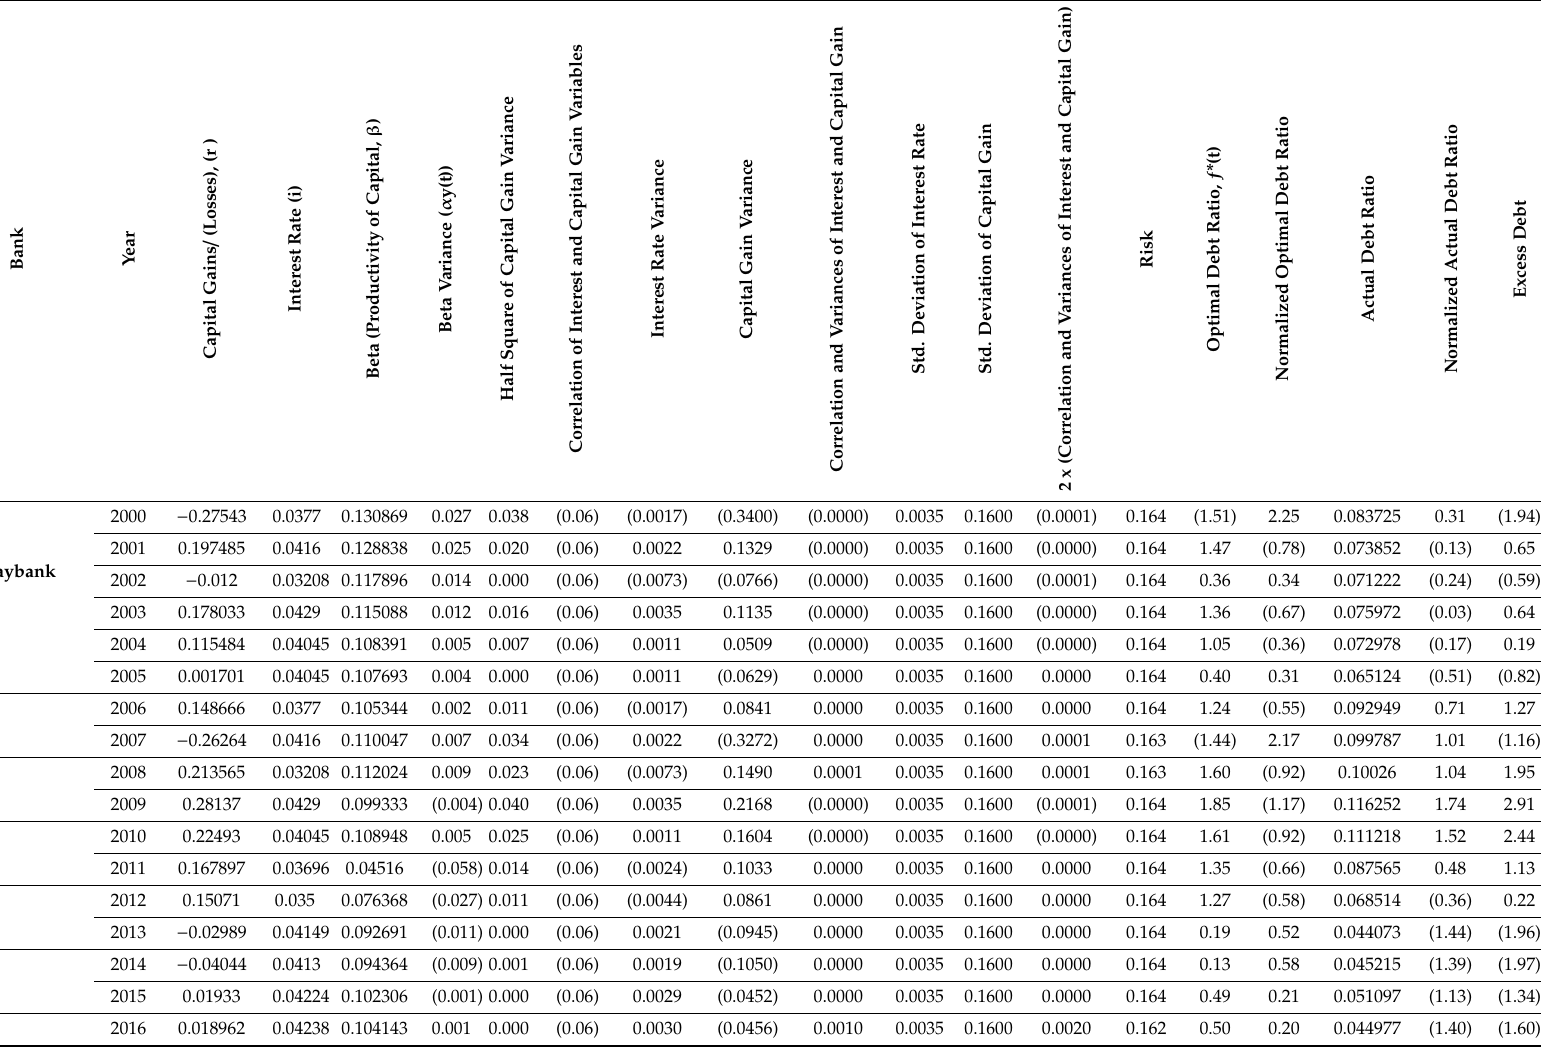
Table A11. Calculations of Optimal and Excess Debt: